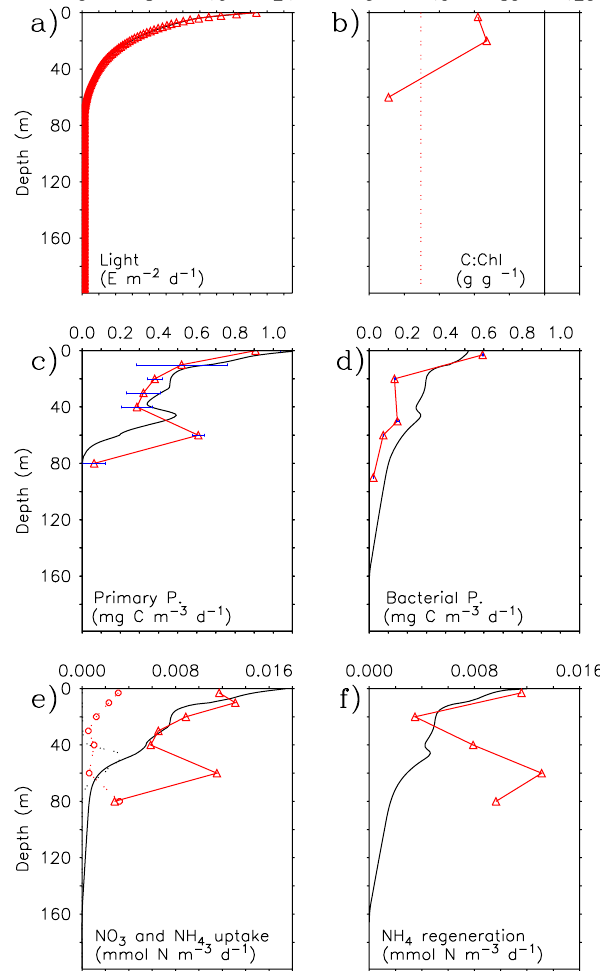
Fig. 10. Model–data comparisons (rates) for the “constant C:Chl” run. Model outputs are in black and observations in red: (a) down- welling PAR, (b) C:Chl ratio (for SP in the model; for the obser- vations derived from Claustre et al., 1999 (see text for details); the vertical dashed line is the mean C:Chl ratio according to DuRand et al., 2002, and Sherr et al., 2003), (c) primary production, (d) bac- terial production, (e) NH 4 and NO 3 uptake (in the model, full and dashed lines, respectively; in the observations, triangles and circles, respectively) and (f) NH 4 regeneration. In (c) and (d) , the aver- ages ± standard deviation appear in